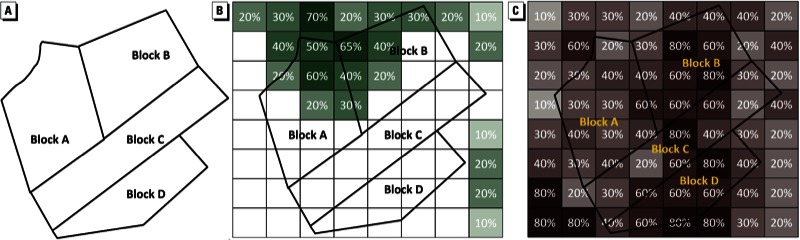
Method for assessing HRRLC characteristics. (A) Four blocks constituting one block group. (B) NLCD tree canopy overlay. (C) NLCD impervious surface overlay.